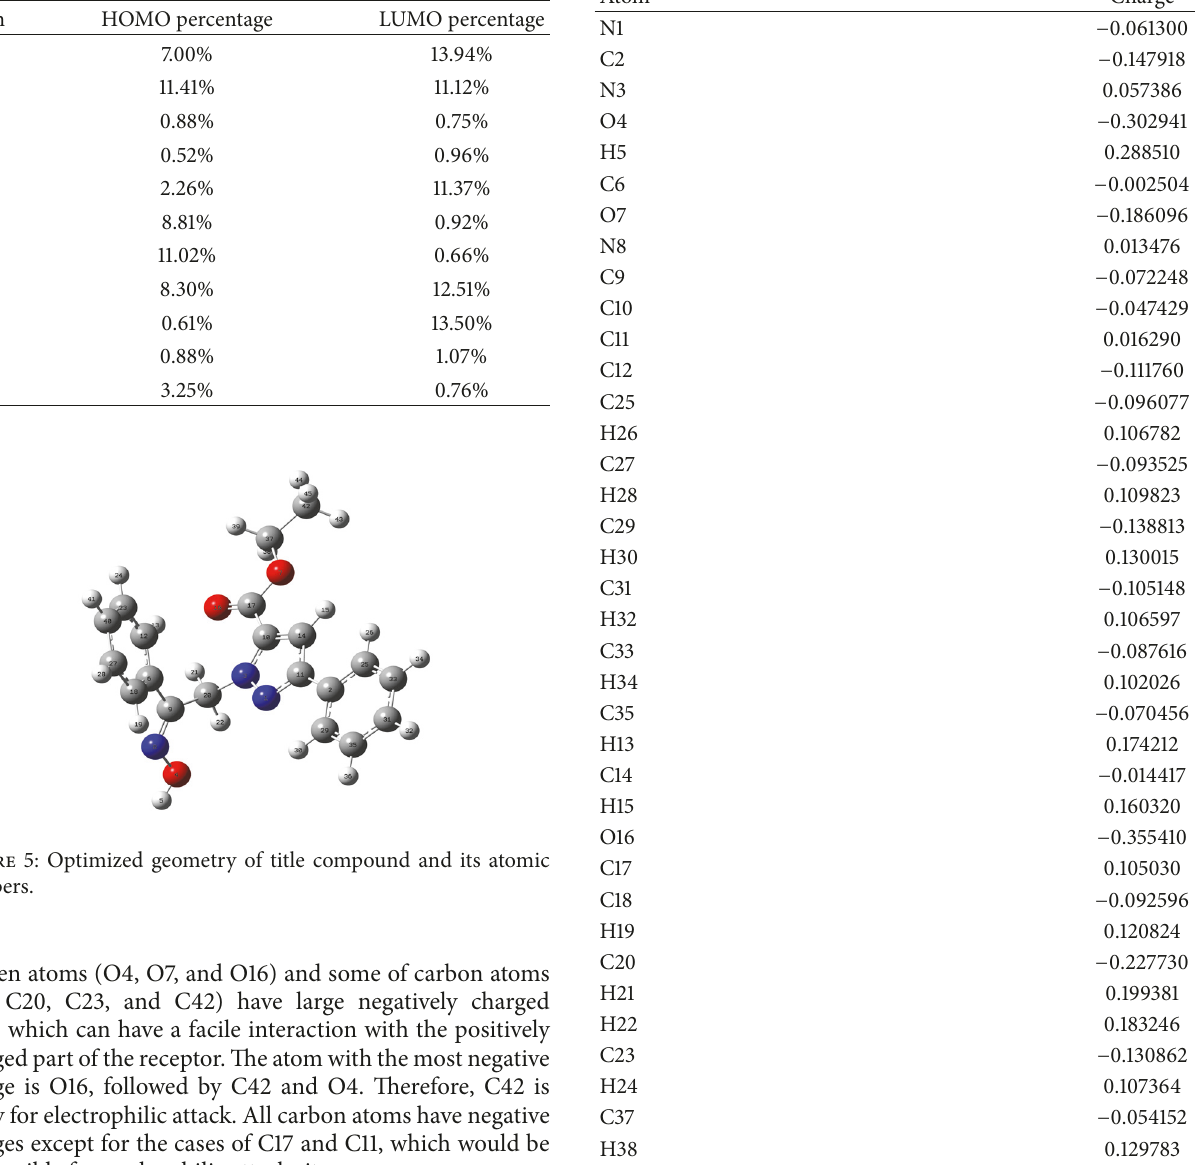
Table 6: Mulliken atomic charges of title